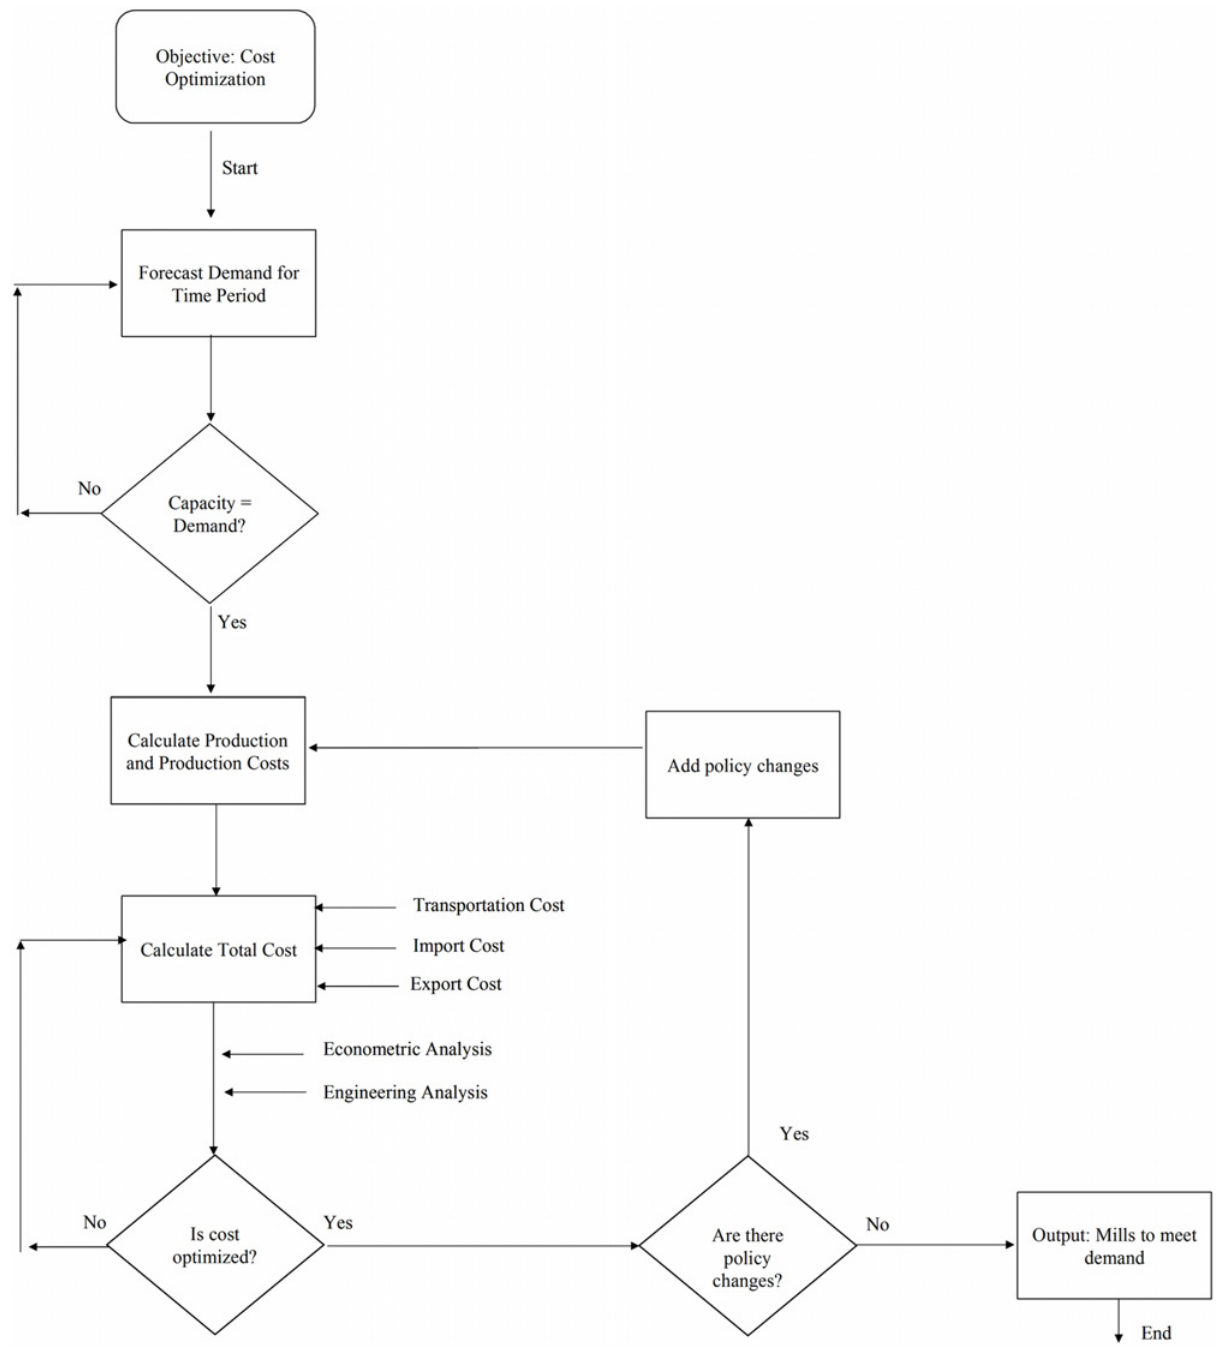
Fig 8. Algorithm used in ISIS model describing the cost optimization